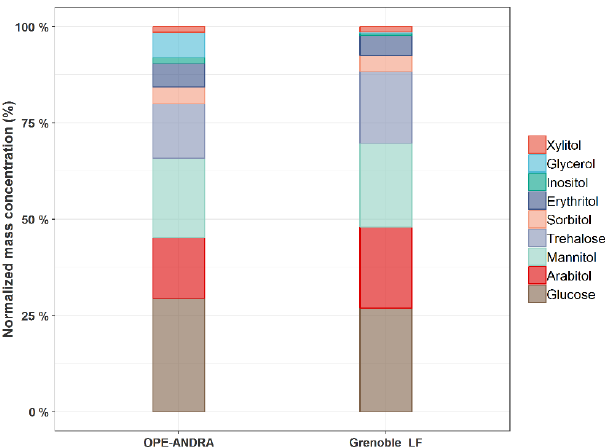
Figure 2. Overview of relative mass distributions of individual pri- mary sugar alcohols and saccharide compounds quantified in PM 10 samples at two sites over summer and autumn periods (June to November) corresponding to maximal atmospheric concentrations of sugar alcohols/saccharide